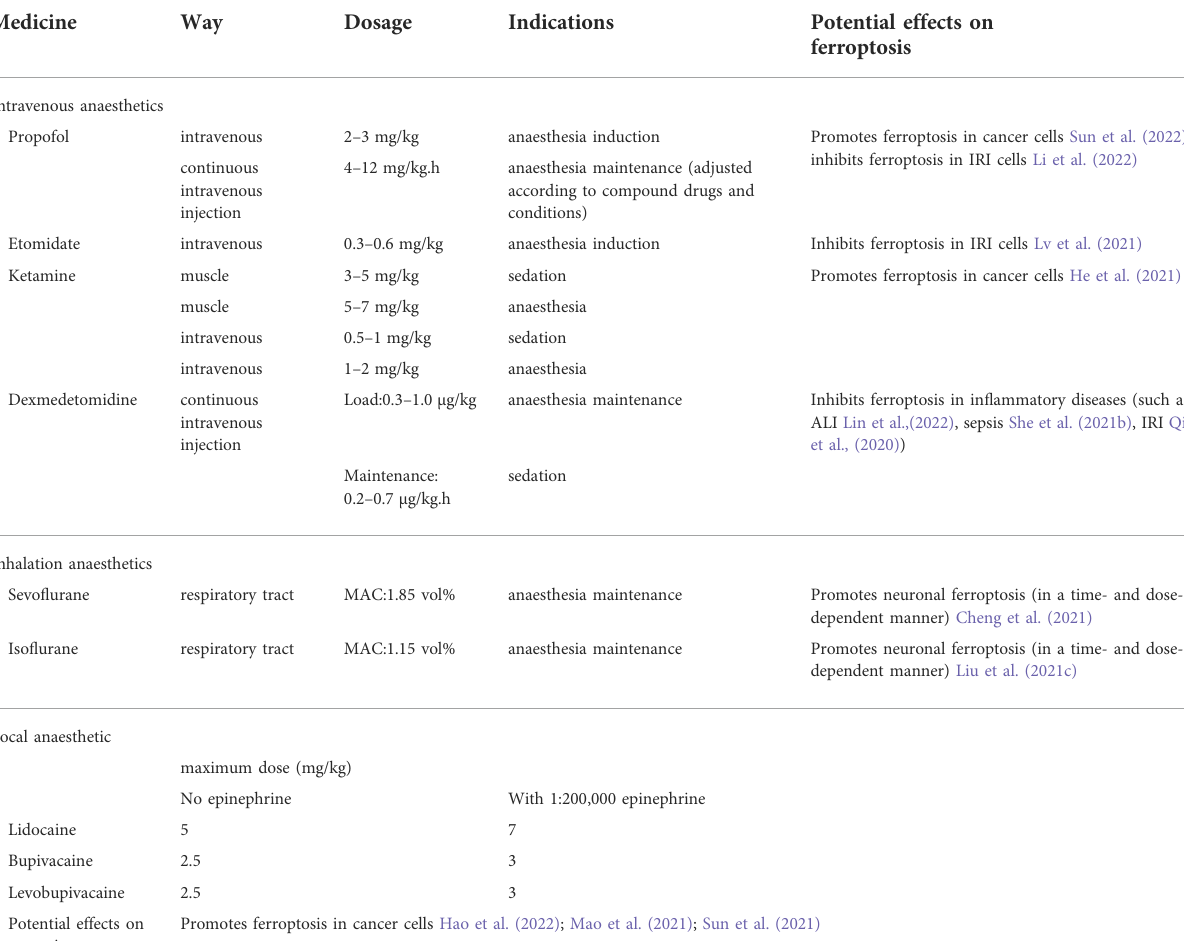
TABLE 2 Dosages, indications and potential effects on ferroptosis of some commonly used anaesthetics in the perioperative